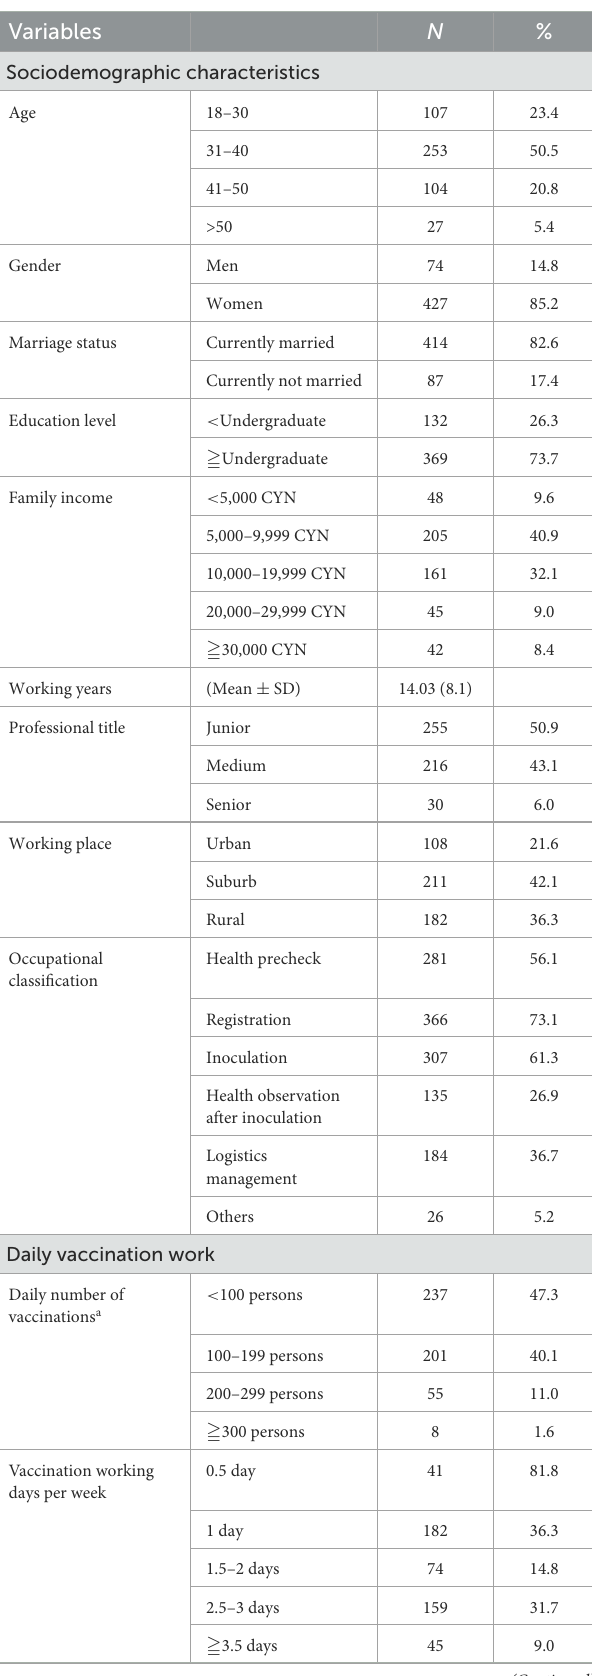
TABLE 1 Social-demographic and work-related situations of